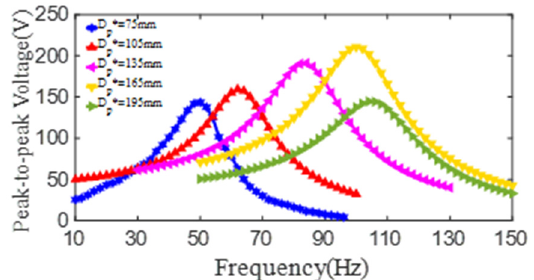
Figure 13. The relationship curves of the peak-to-peak voltage and the excitation frequency of PZT4 patch with different outer diameter ( d p* = 20 mm, t p* = 1 mm, t s* = 0.6 mm).